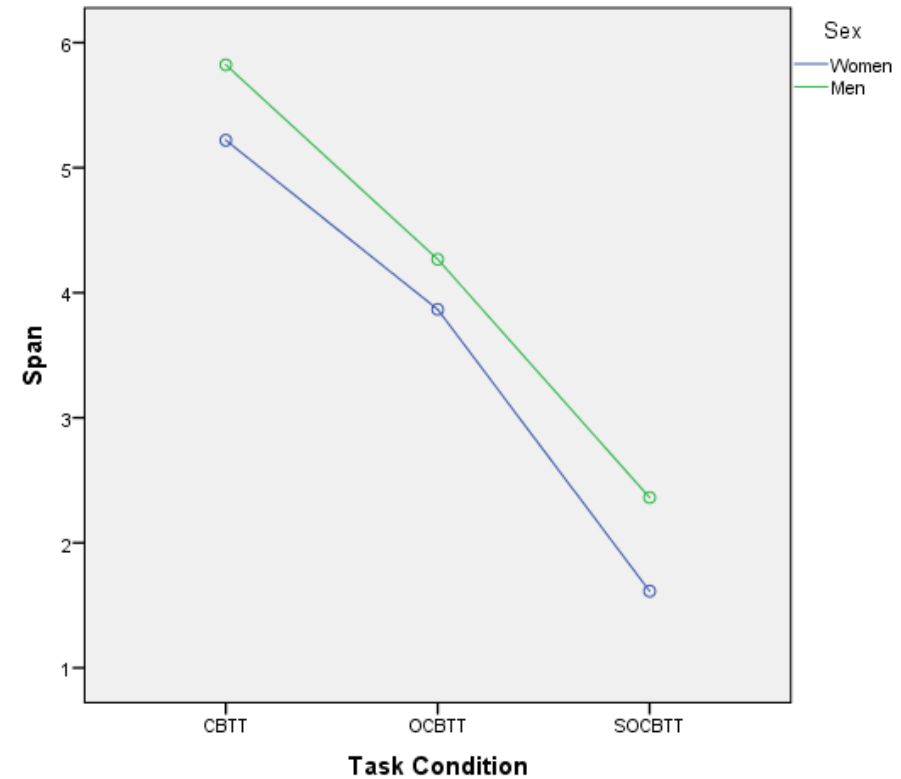
Figure 2. Gender difference and span expressed in the different task conditions (i.e., CBTT; OCBTT and SOCBTT).